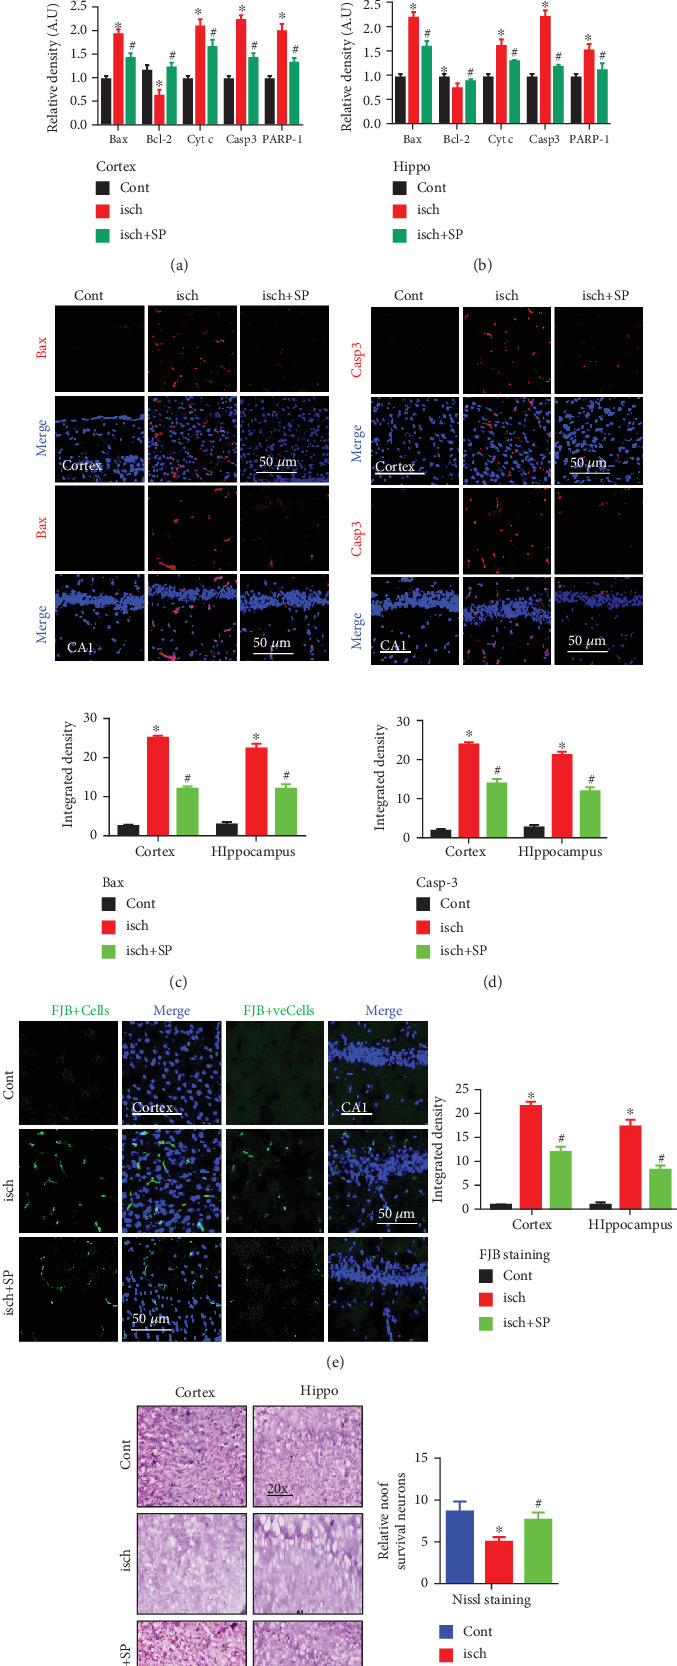
Chronic ischemic condition upregulates neuronal apoptosis and neurodegeneration. (a, b) Western blot results of apoptosis-related markers. β-Actin was used as a loading control and ∗P < 0.05, #P < 0.05. Density values are expressed in arbitrary units (A.U). (c, d) Results of immunofluorescent analysis for apoptotic markers. (e) Showing FJB results while (f) Specify nissl staining results. The nissl staining result magnification was 20x. GraphPad Prism 6.0 soft was used to determine the significance level.